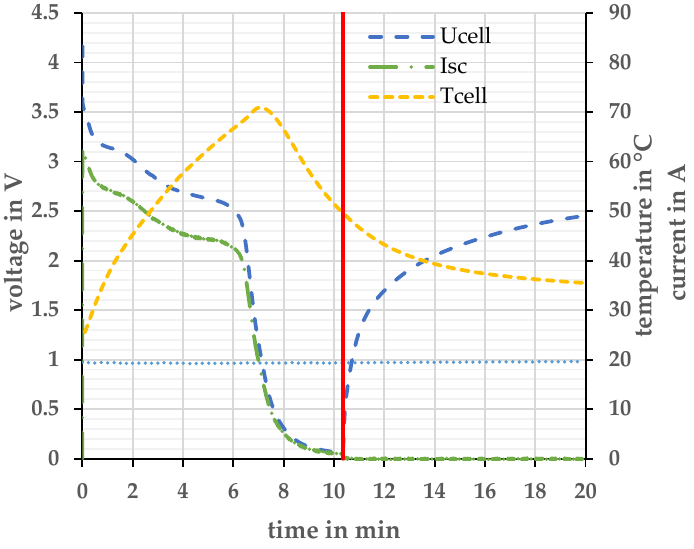
Figure 6 . Voltage and current profile at short-circuit test at T ambient = 20 ± 2 °C. The red line describes the moment when the short circuit is canceled again.